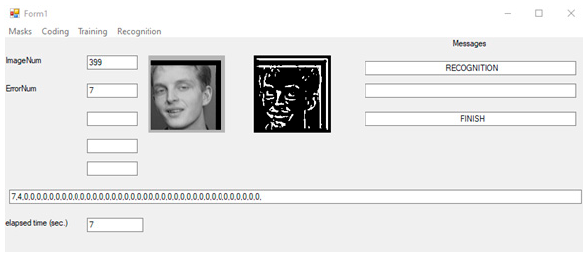
Figure 19. Example of face recognition for the ORL database.